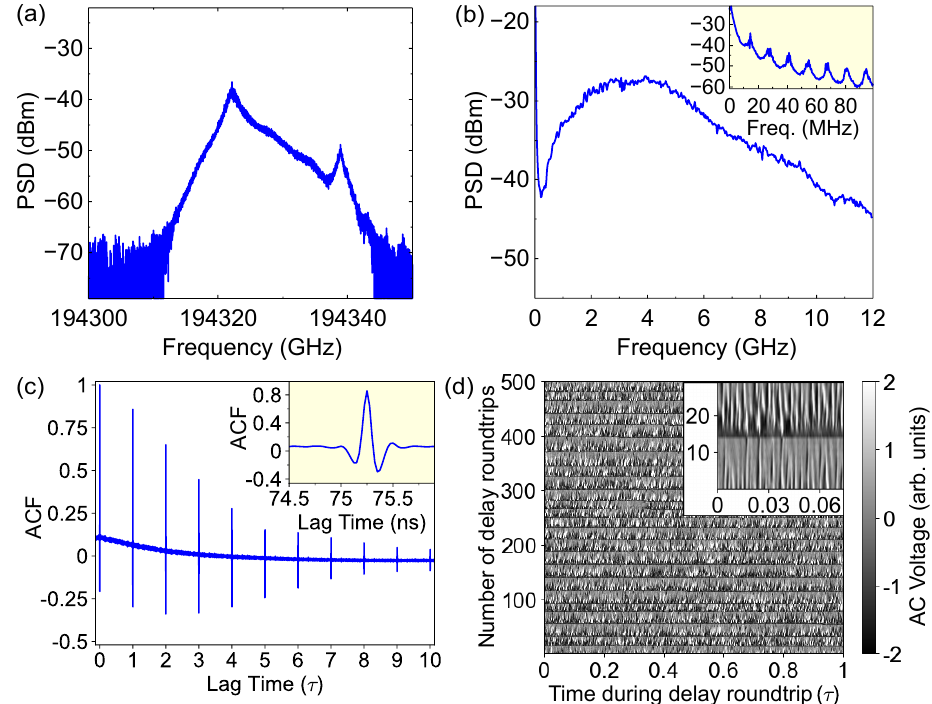
Figure 9. High feedback rate dynamics. The bias current is I = 13 mA and the feedback rate is the maximum value allowed in the experimental set-up. ( a ) Optical spectrum, ( b ) RF power spectrum, ( c ) Autocorrelation function (ACF) of the intensity time series with inset around the first delay echo, ( d ) Spatio-temporal representation of the intensity time series with inset for magnification around the